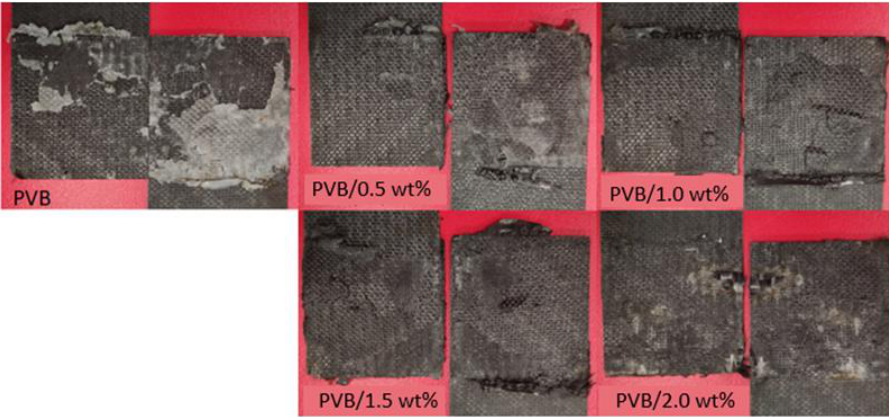
Figure 8. Fracture surfaces of CF/Epoxy LSS joints at different filler content.